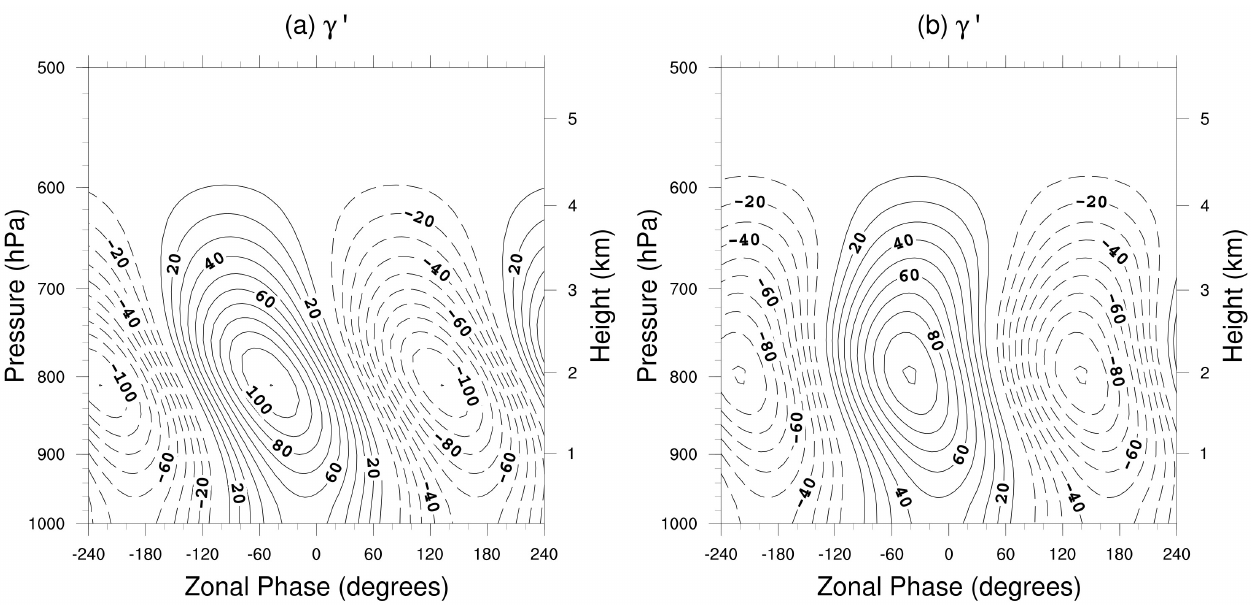
Figure 4. Vertical structures of the perturbation dust field, γ (cid:48) , at 18 ◦ N for the ( a ) passive and ( b ) active experiments. Contour intervals are 10 µ g kg − 1